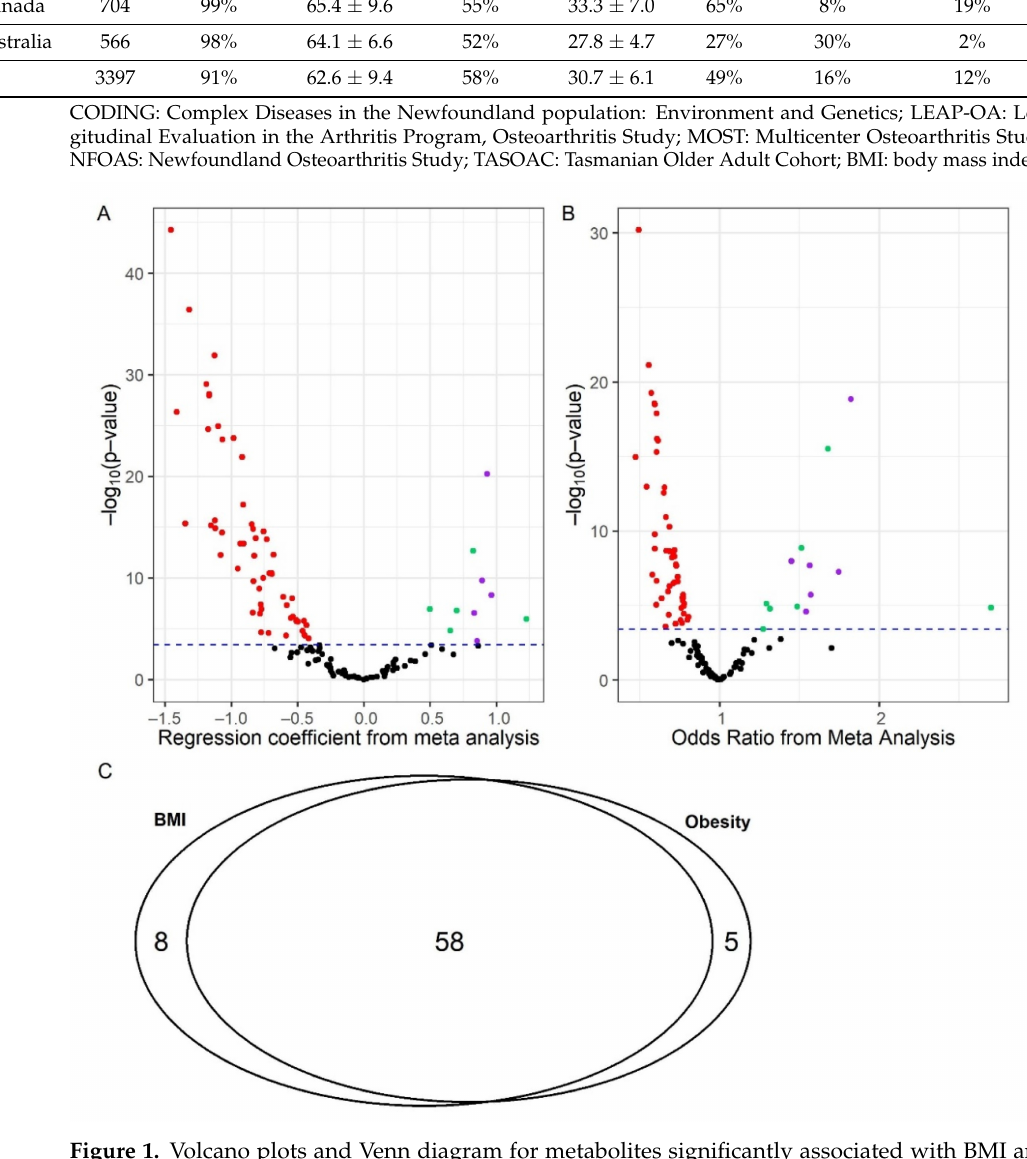
Figure 1. Volcano plots and Venn diagram for metabolites significantly associated with BMI and Obesity. ( A ) Metabolites significantly associated with BMI; ( B ) metabolites significantly associated with obesity; ( C ) number of metabolites associated with both BMI and obesity. BMI: body mass index. ( A , B ) Red indicates metabolites significantly negatively associated with body mass index or obesity; green indicates metabolites significantly positively associated with body mass index or obesity; black indicates metabolites not significantly associated with body mass index or obesity; purple indicates major amino acids significantly associated with body mass index or obesity which are presented in the forest plots in Figure